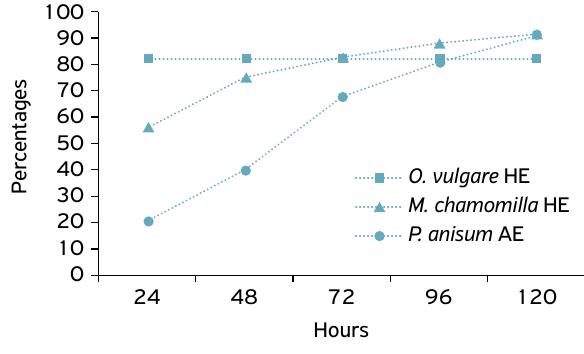
Figure 1. Mortality percentages of Tetranychus urticae females sprayed with plant extracts up to 120 hours after